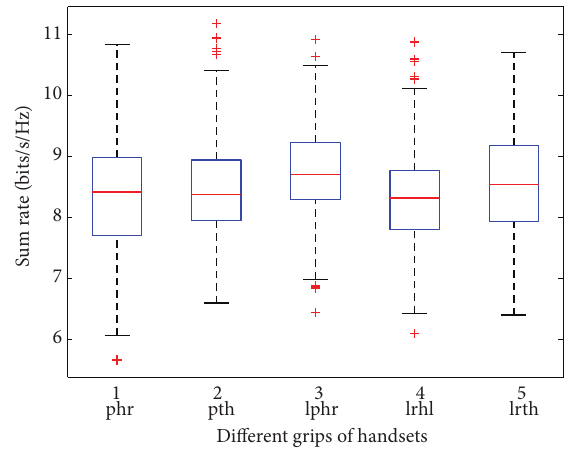
Figure 6: Capacity of different grips at low band.